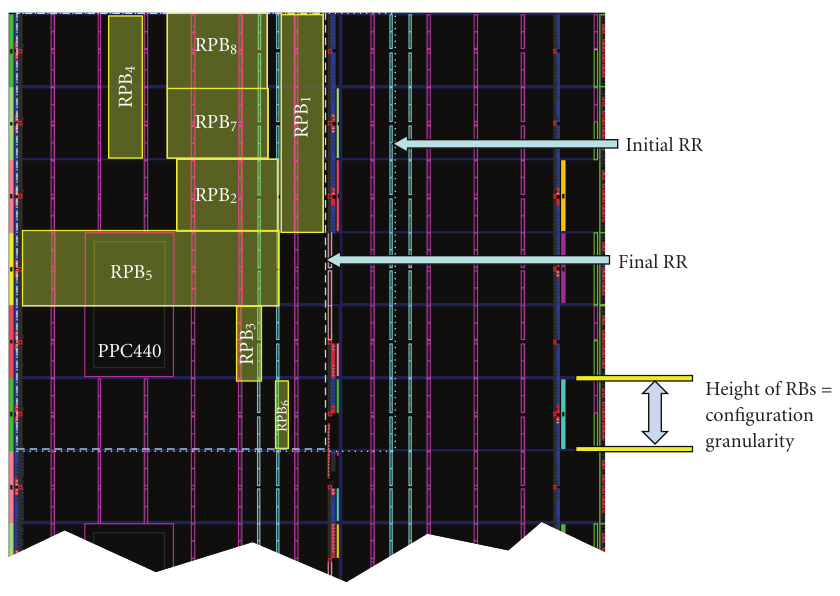
Figure 7: Floorplanning of RPBs on Virtex 5